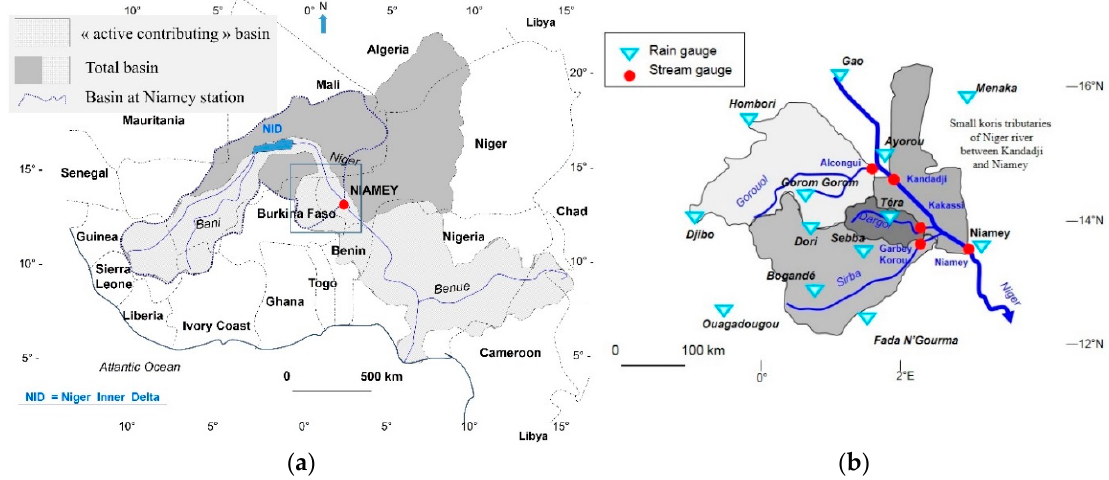
Figure 1. ( a ) Location of Middle Niger River Basin (MNRB); ( b ) topographical Gorouol, Dargol and Sirba basins with stream gauges and rain gauges location.